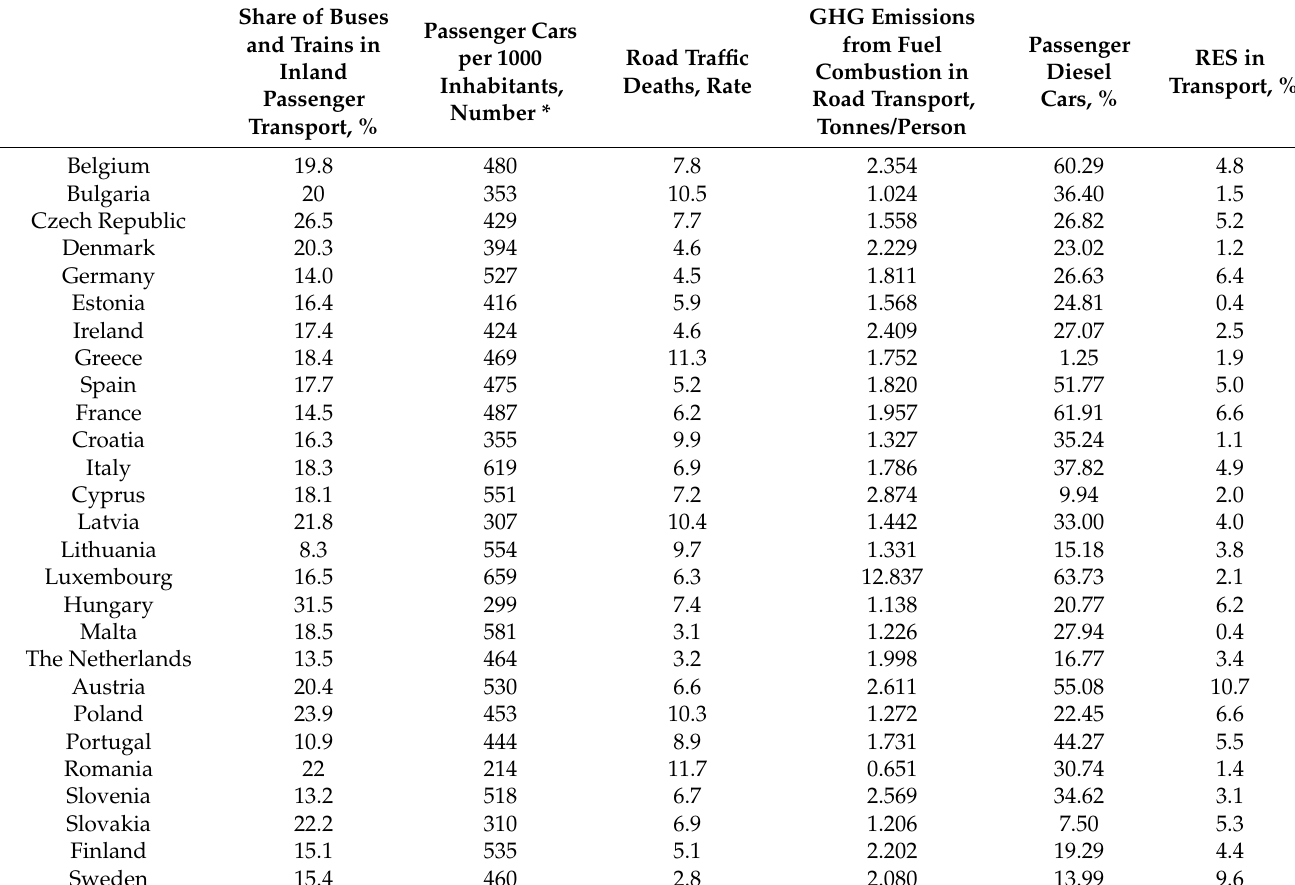
Table A1. Road transport indicators of EU member states in 2010. Source: